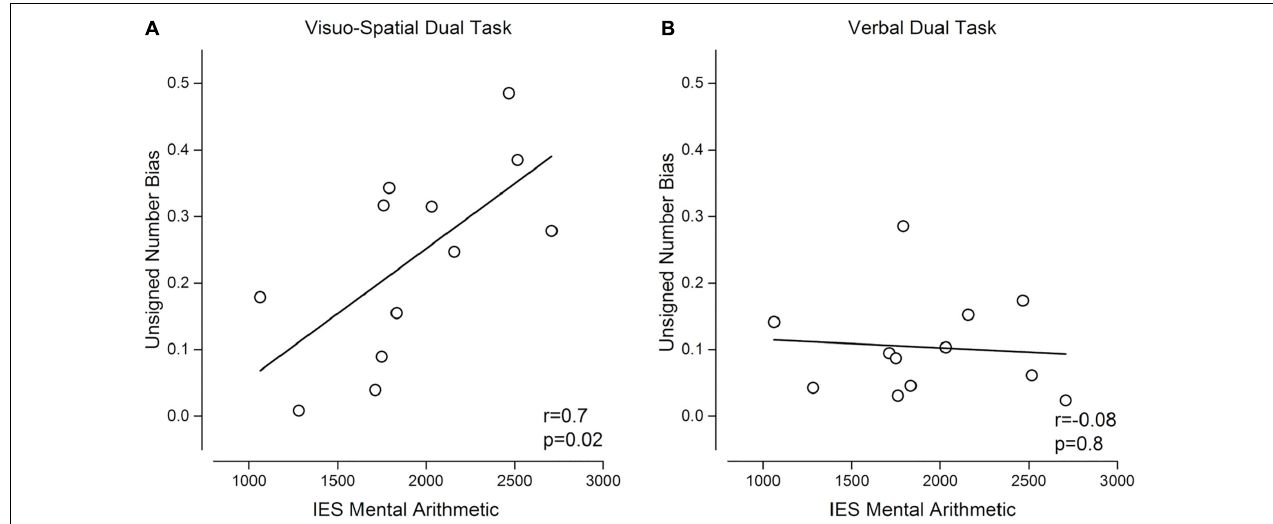
FIGURE 6 | Relation between unsigned bias and mental arithmetic skills. Pearson correlation between unsigned bias when discriminating numerosity during the visuo-spatial (A) or verbal (B) dual tasks and inverse efficiency score (IES, see section “Arithmetic Test”) in mental